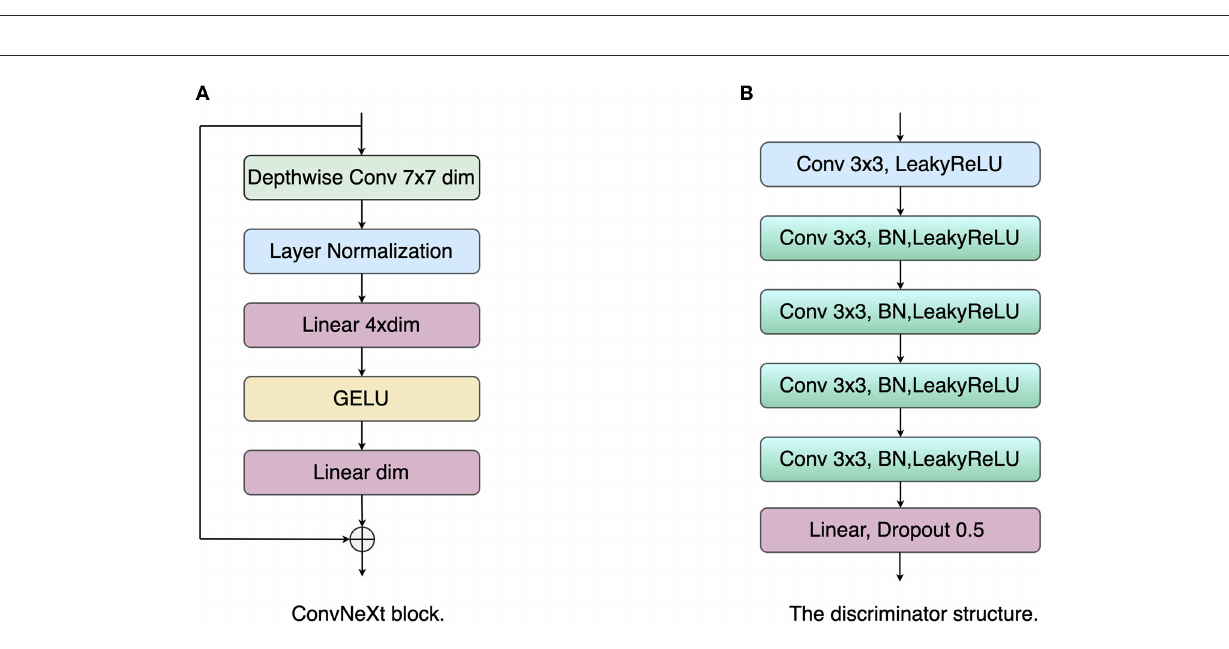
FIGURE2 The structure illustrations of the ConvNeXt block and discriminator. (A) ConvNeXt block; (B) Discriminator network.